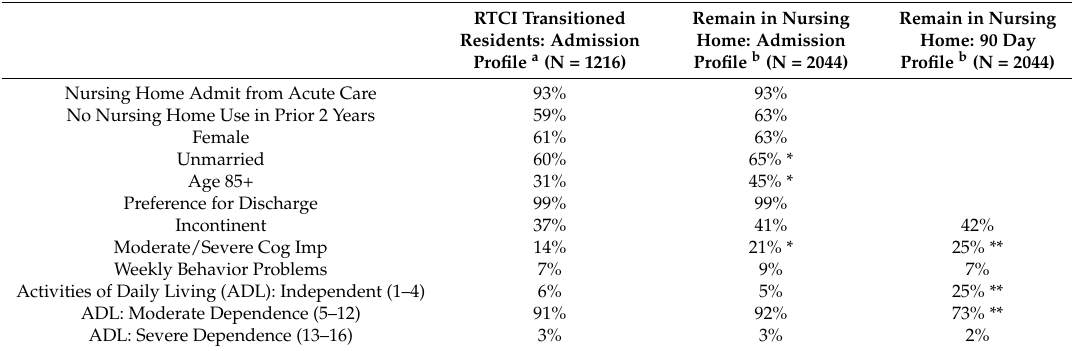
Table 1. Characteristics of target group residents transitioned by the Return to Community Initiative (RTCI) and residents remaining in the nursing home at 90 Days.